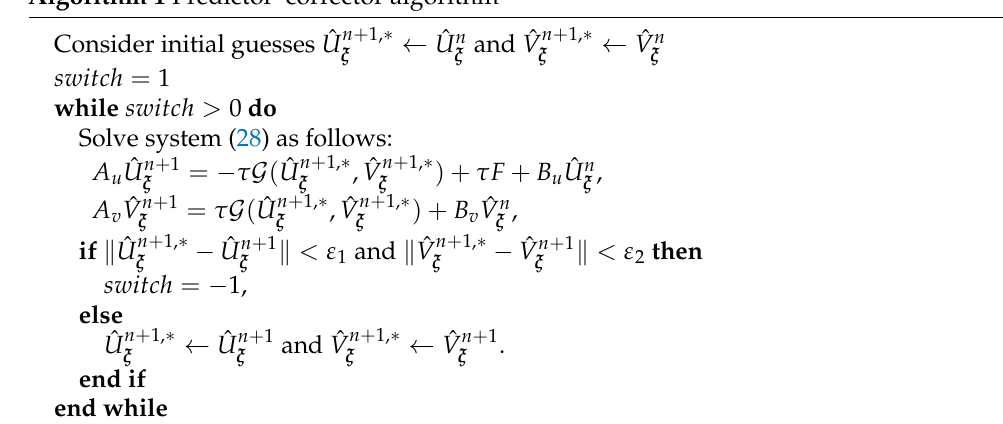
Algorithm 1 Predictor–corrector